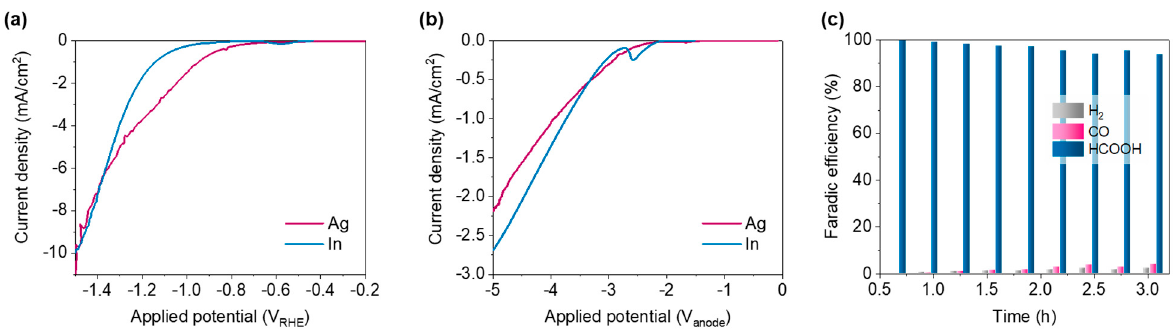
Figure 4. Linear sweep voltammograms for ( a ) small electrochemical cell and ( b ) big electrochemical cell. ( c ) Product distributions against time for In in the big electrochemical cell (the current density is kept at ~0.5 mA/cm 2 ).